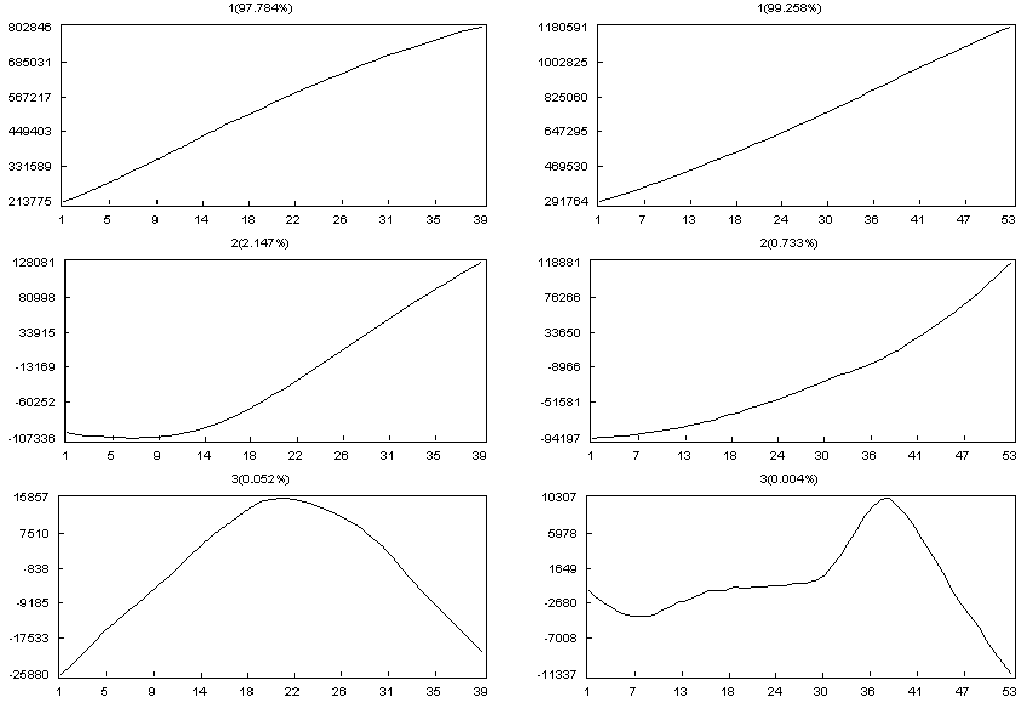
Figure 17. Principal components related to the first three eigentriples.